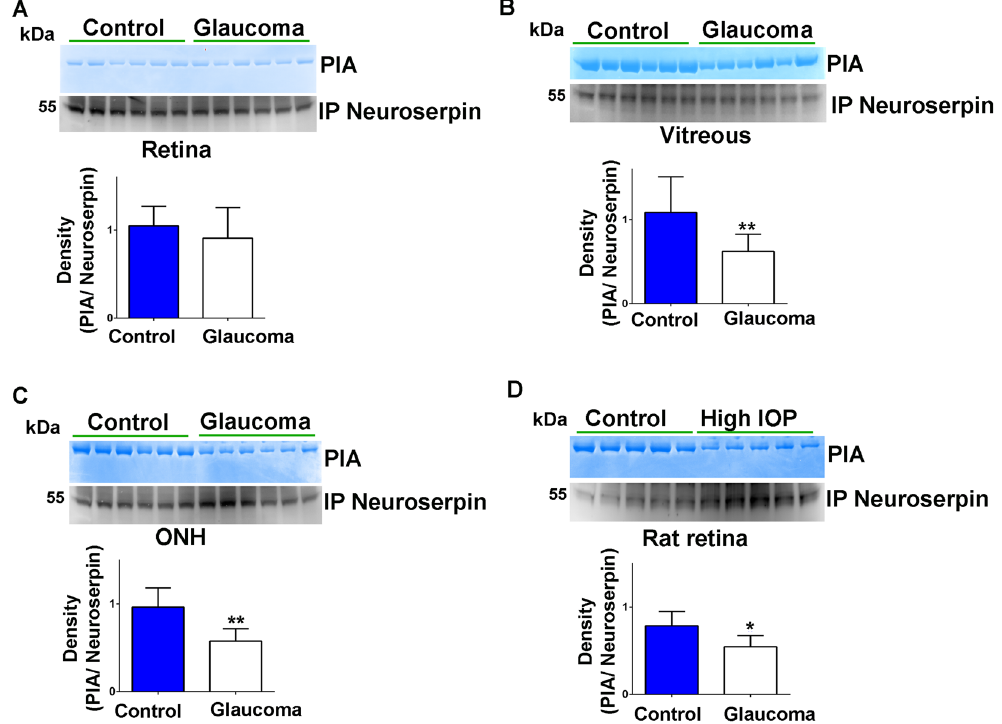
Figure 5. Neuroserpin was immunoprecipitated from ( A ) human retinal ( B ) vitreous and ( C ) ONH tissue lysates using anti-neuroserpin antibody and subjected to gelatin zymography to evaluate the plasmin inhibitory activity of the neuroserpin (n = 6 each). ( D ) Immunoprecipitated neuroserpin from control and high IOP rat retinas were subjected to gelatin gel zymography to assess its plasmin inhibitory activity (n = 5). Immunoprecipitates were also loaded for western blotting and developed for neuroserpin immunoreactivity in each case. Blots were cropped to show the relevant band. Relative band intensities were quantified and data analysis indicated significantly decreased plasmin inhibitory activity in human vitreous and ONH glaucoma samples and high IOP induced rat retinas compared to the respective controls ( * p < 0.05; ** p <